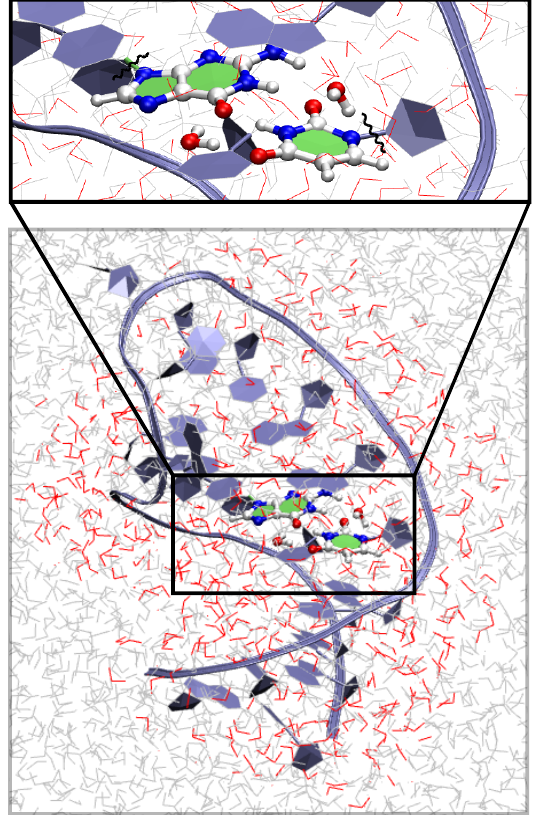
Figure 2. QM/MM simulation system. The G • U base pair (without the phosphate and sugar groups) and two water molecules (in balls and sticks representation) are included in the QM-region. Waters shown in red belong to the MM-active region, and the rest (gray) is the MM-frozen